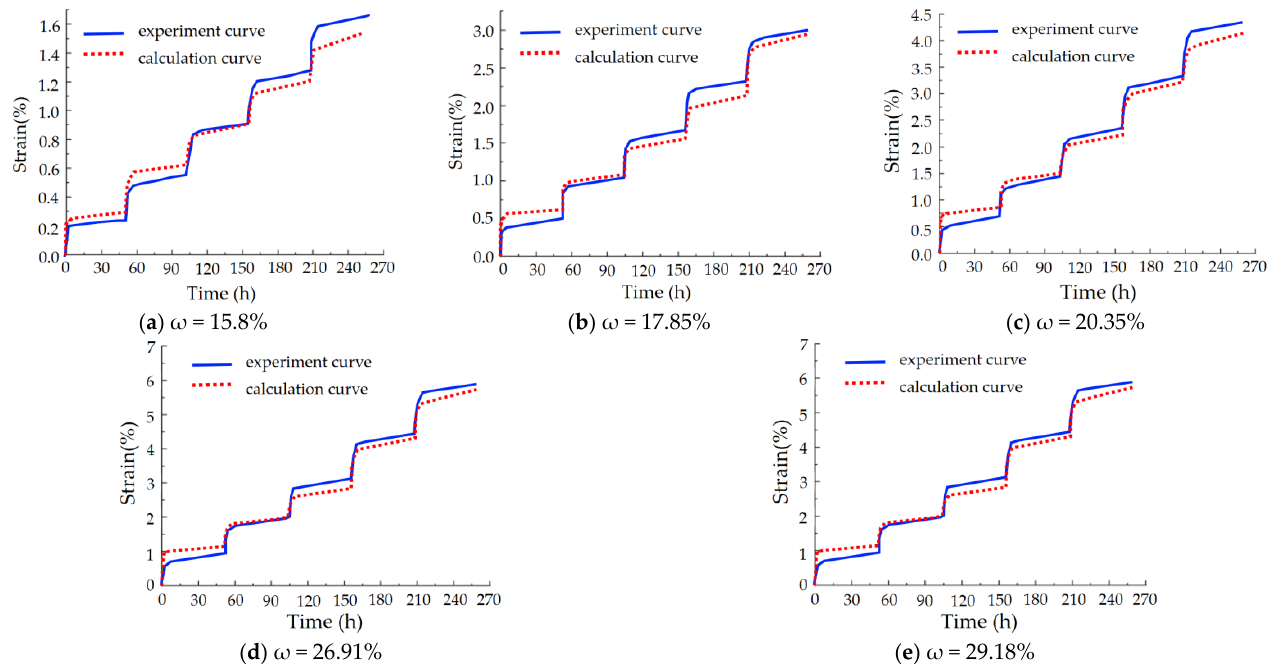
Figure 9. Experiment curve and calculation curve of specimens: ( a ) ω = 15.8%, ( b ) ω = 17.85%, ( c ) ω = 20.35%, ( d ) ω = 26.91% and ( e ) ω = 29.18%.